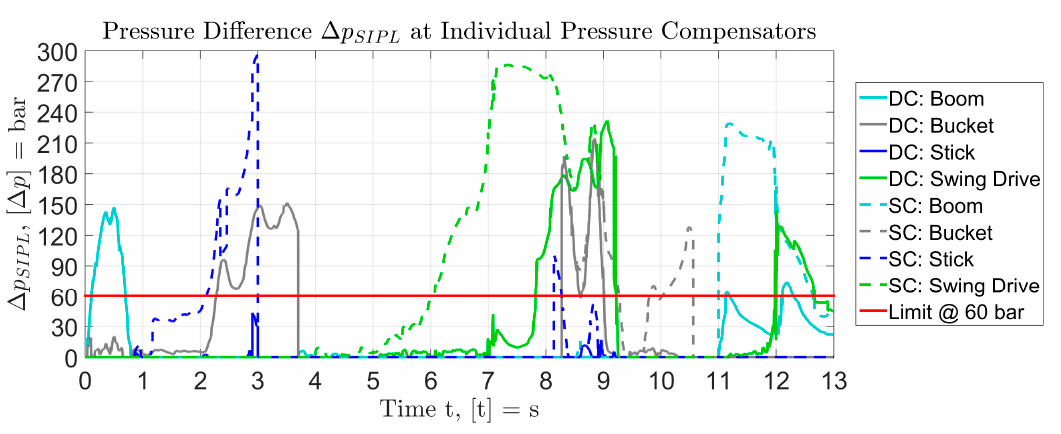
Figure 5. Analysis of 90 degree digging cycle, pressure difference ∆ p SIPL at pressure compensators.